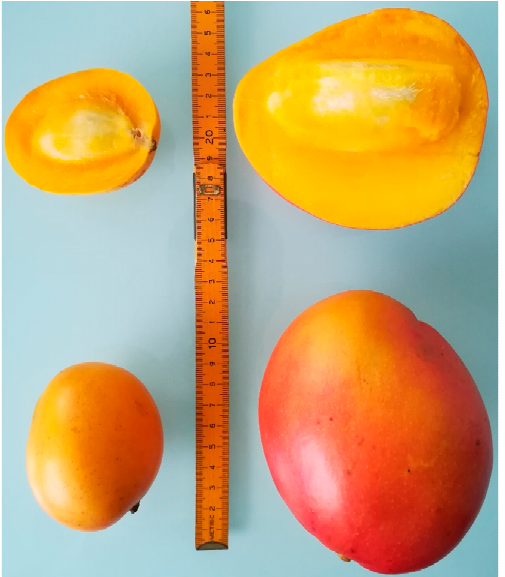
Figure 1. Colombian mango cultivars: ‘sugar mango’ (left) and ‘Tommy Atkins’ (right).